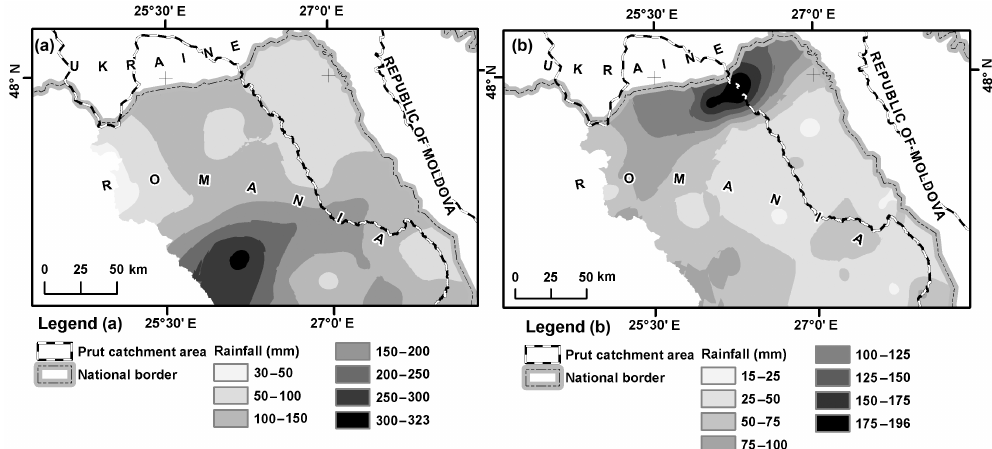
Figure 5. Cumulative precipitation amounts, in north-eastern part of Romania, from 21 to 27 June 2010 (left) and 28 June to 1 July 2010 (right).